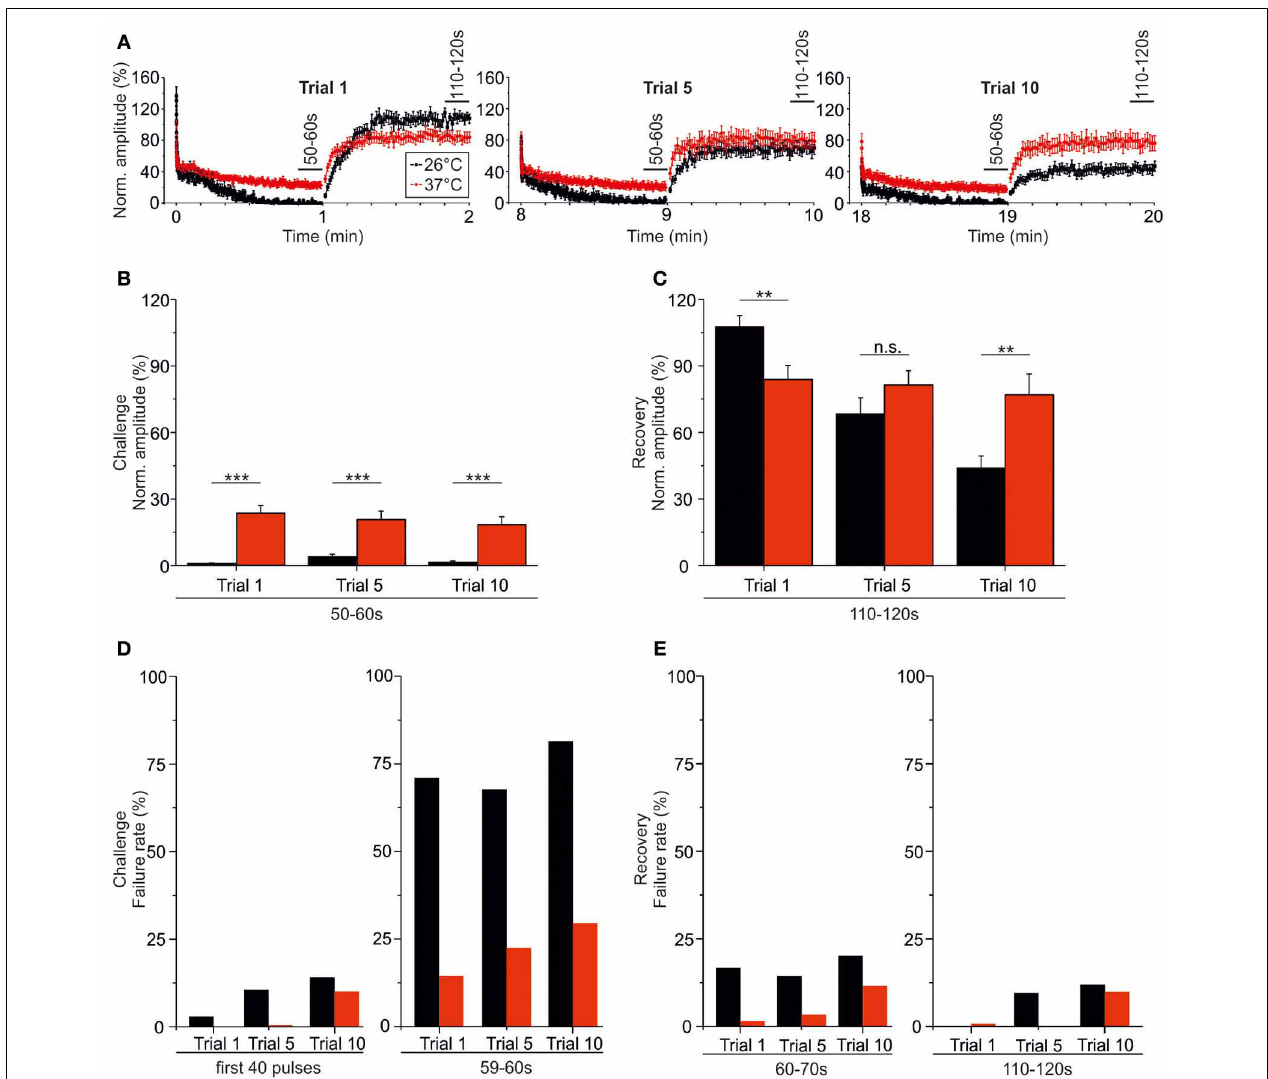
FIGURE 12 | Temperature effect on synaptic attenuation and recovery as assessed during very prolonged stimulation (20min). (A) Superposition of averaged time courses depicted in Figures 10 , 12 (26 ◦ C in black, 37 ◦ C in red), highlighting the temperature-dependent differences. (B) Statistical analysis of IPSC peak amplitudes at the end of the challenge